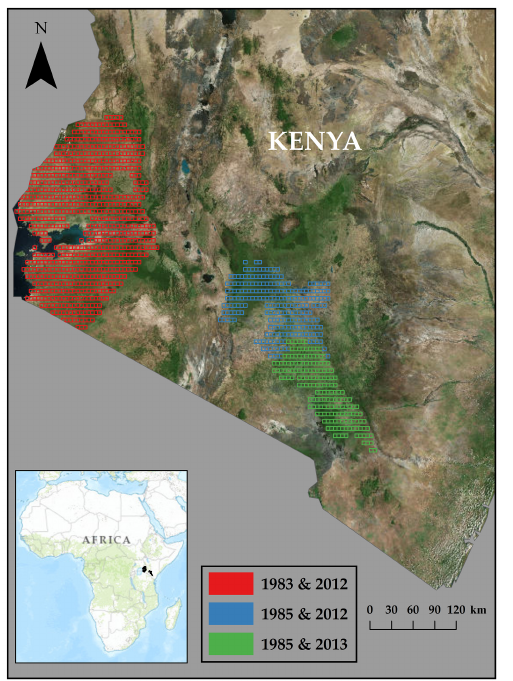
Figure 1. Study area: 112625km 2 sample frames demarcating the proportion of land use/cover types estimated from aerial photo in- terpretation and ground surveys. Photos were taken and surveys were performed in western Kenya in 1983 and 2012, north-central Kenya (Machakos area) in 1985 and 2012, and south-central Kenya (Makueni area) in 1985 and 2013. Source of remote sensing im- age and topographic map: Environmental Systems Research Insti- tute